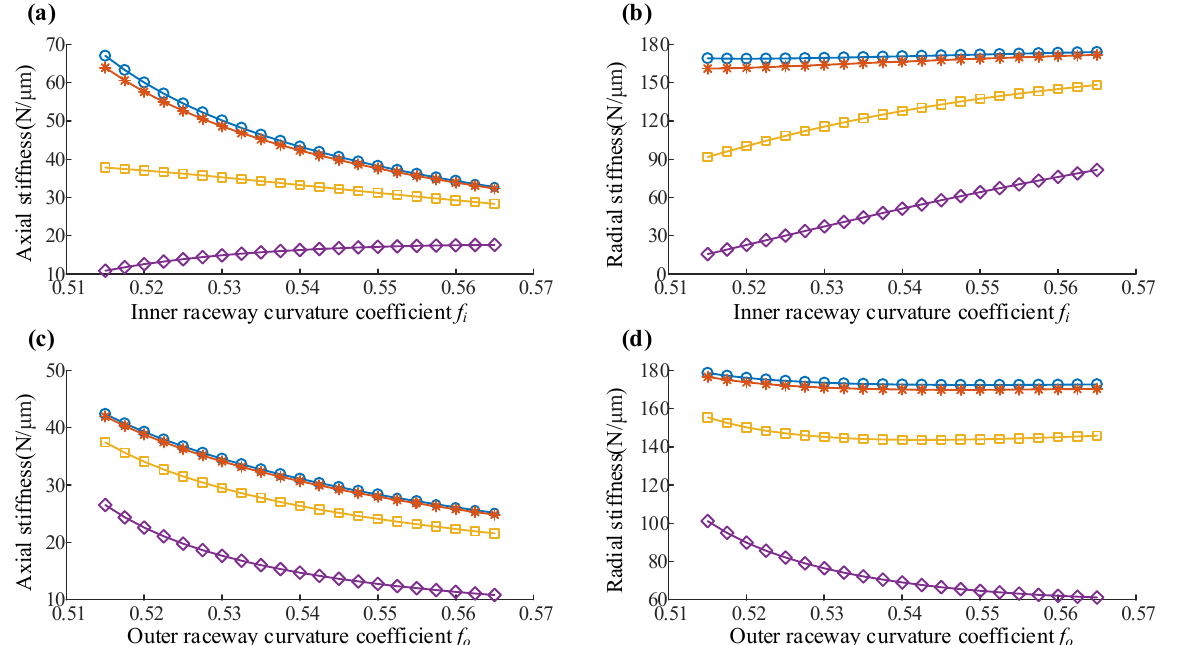
Figure 13. The influences of raceway curvature coefficient on bearing stiffness: ( a ) bearing axial stiffness varies with inner raceway curvature coefficient f i ; ( b ) bearing radial stiffness varies with inner raceway curvature coefficient f i ; ( c ) bearing axial stiffness varies with outer raceway curvature coefficient f o ; ( d ) bearing radial stiffness varies with outer raceway curvature coefficient f o ( — ○ — rotating speed = 0 rpm, — ∗ — rotating speed = 5000 rpm, — □ — rotating speed =10000 rpm, — ◇ — rotating speed = 20,000 rpm).